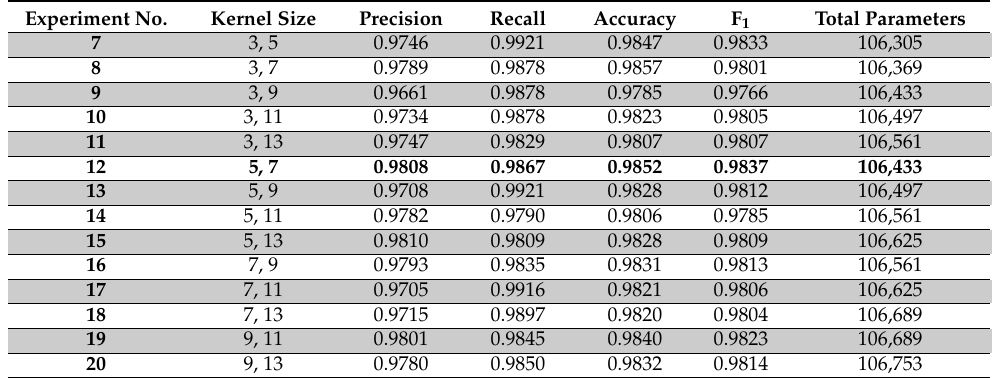
Table 8. Classification performance of the model for two scales with different kernel sizes.